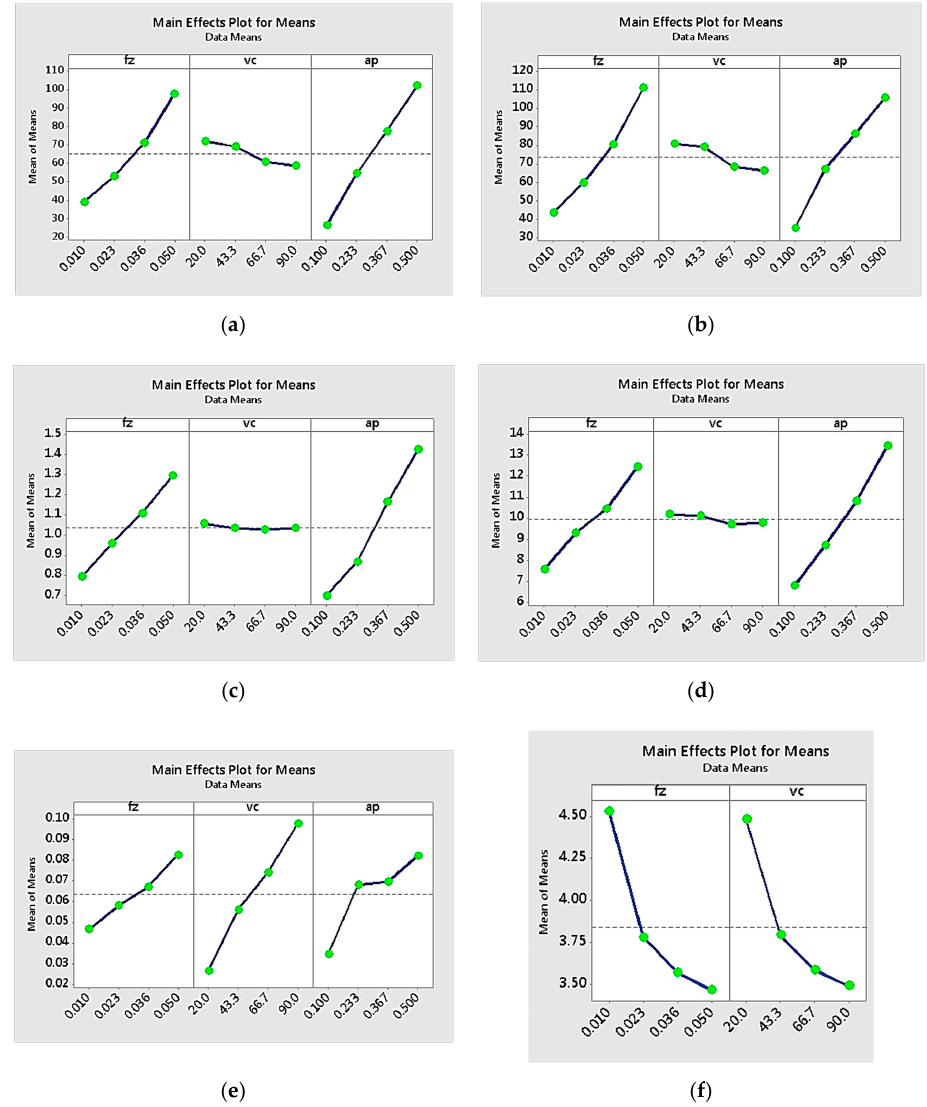
Figure 5. Main effect plots for: ( a ) F x force component, ( b ) F y force component, ( c ) Ra , ( d ) Rt , ( e ) power consumption P c , and ( f ) machining cost C i . consumption P c , and ( f ) machining cost C i